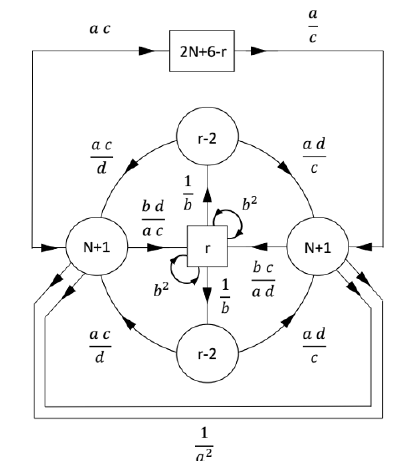
Figure 6. The theory we get after performing Intriligator-Pouliot duality on the two USp groups in the theory in (cid:12)gure 5 (b). Here the groups with r are related as stated in (cid:12)gure